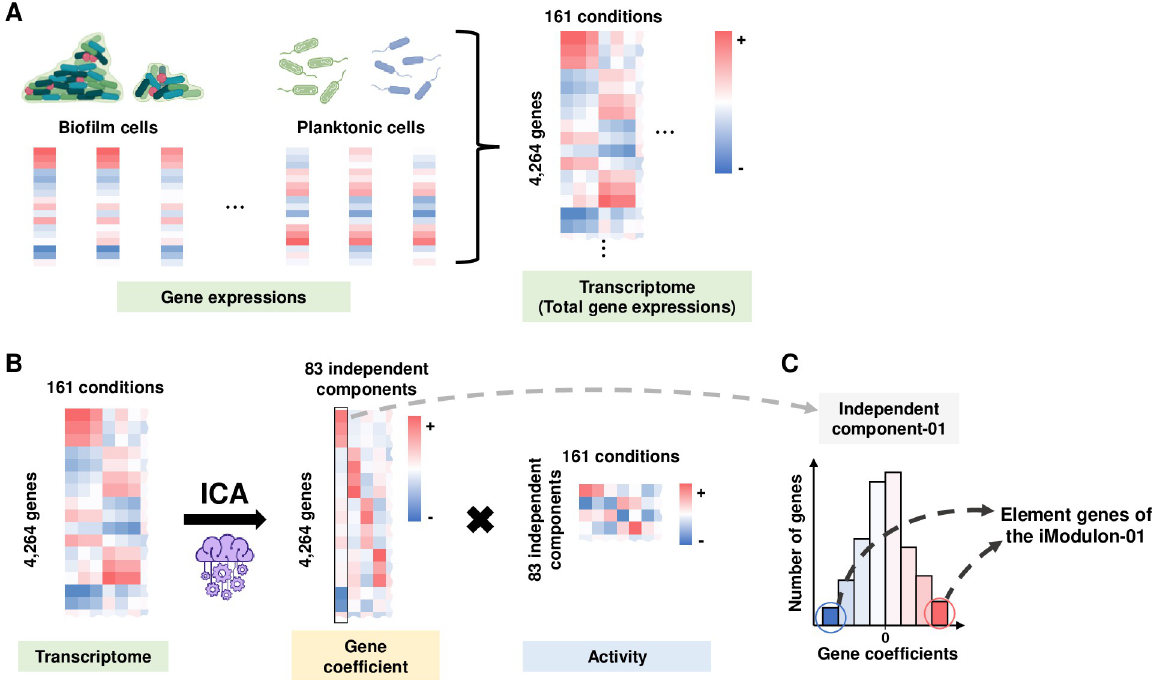
Fig 1. Graphical illustration of the overall ICA workflow. (A) Individual gene expression profiles from biofilm and planktonic cells under a total of 161 conditions were combined into the large-scale transcriptome data. Red and blue represent the high and low expression levels of the genes, respectively. (B) ICA decomposed the transcriptome data into 83 independent components and outputted two matrices, ‘Gene coefficient’ and ‘Activity’. The ‘Gene coefficient’ matrix displayed the varied gene coefficients of 4,264 genes constituting the 83 independent components (S3 Dataset). The ‘Activity’ matrix indicated the activities of each independent component along the 161 conditions (S4 Dataset). (C) The independent component-01 was converted into the iModulon-01 by selecting the genes with significant gene coefficients. The same procedure was applied to the remaining 82 independent